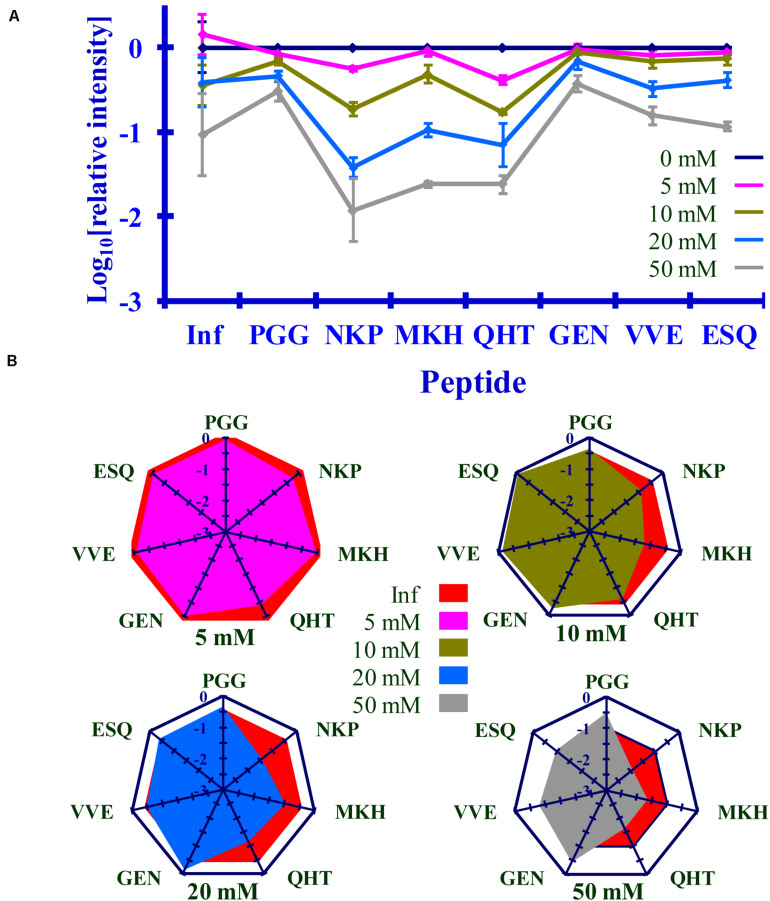
Comparison of the changes in infectivity (Inf) (log10) to the normalized MRM transition signals (log10) of five tryptic peptides (PGGWNTGGSR, QHTVTTTTK, GENFTETDIK, VVEQMCTTQYQK, and ESQAYYDGR), one chymotryptic peptide (NKPSKPKTNM), and the 3F4 epitope (MKHM) after the reaction of Ac2O with PrPSc-infected brain homogenate. (A) Graphical summary of this data. (B) Radar plots of this data. Each PrPSc reaction was performed in triplicate. Hamster bioassay (n = 6 per reagent concentration) was used to measure the infectivity. The locations of the peptides may be found in Figure 2.